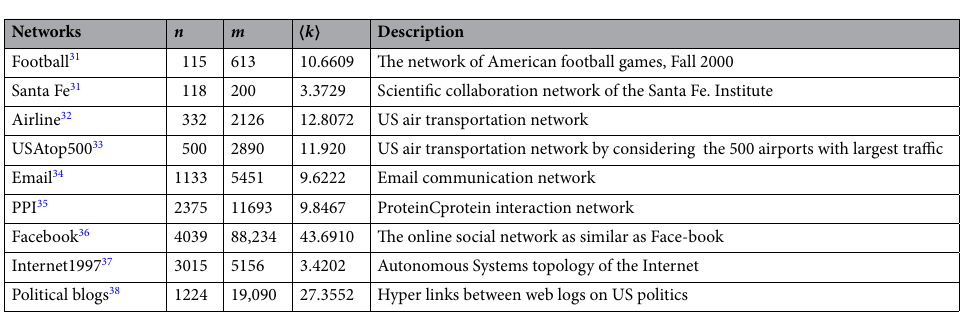
Table 1. Description of real